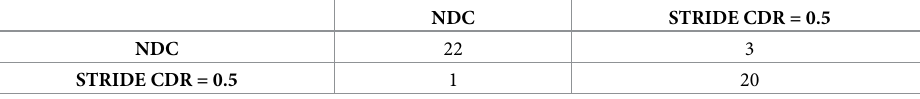
Table 2. Detection of Mild Cognitive Impairment in STRIDE HFR patients (CDR = 0.5) using AD-driven MCI biomarkers and Random Forest (RF) analysis.